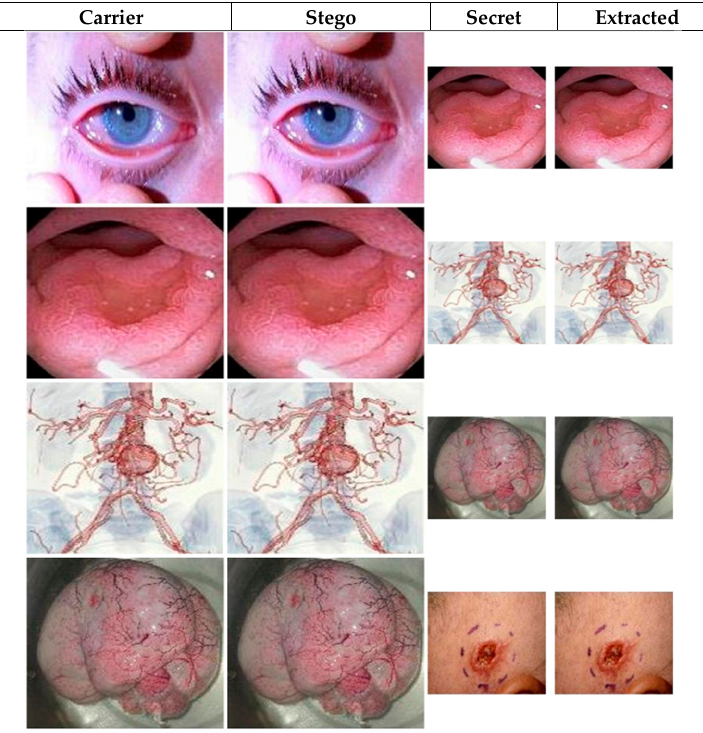
Figure 4. Visual quality for marked (i.e. stego) versions of colour images in Figure 3. 2020 , 10 , x FOR PEER REVIEW